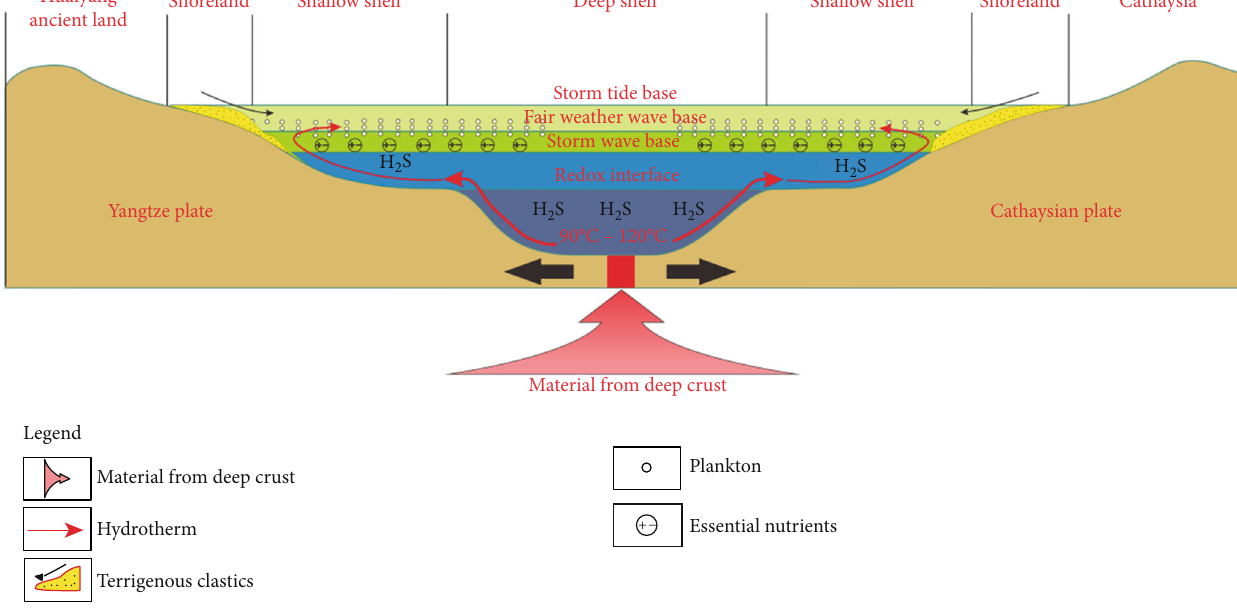
Huaiyang ancient land